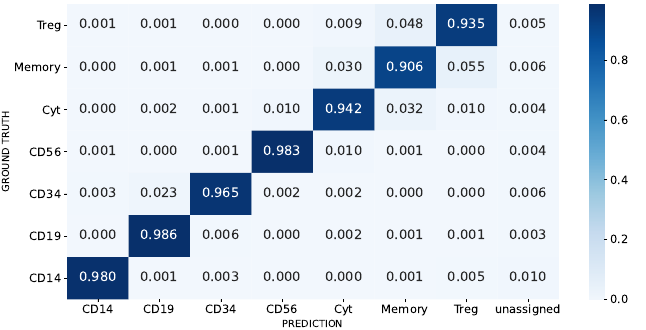
Figure 4. PBMC aggregated cross-validation confusion matrix. The unassigned label refers to cells that the model could not assign a known cell